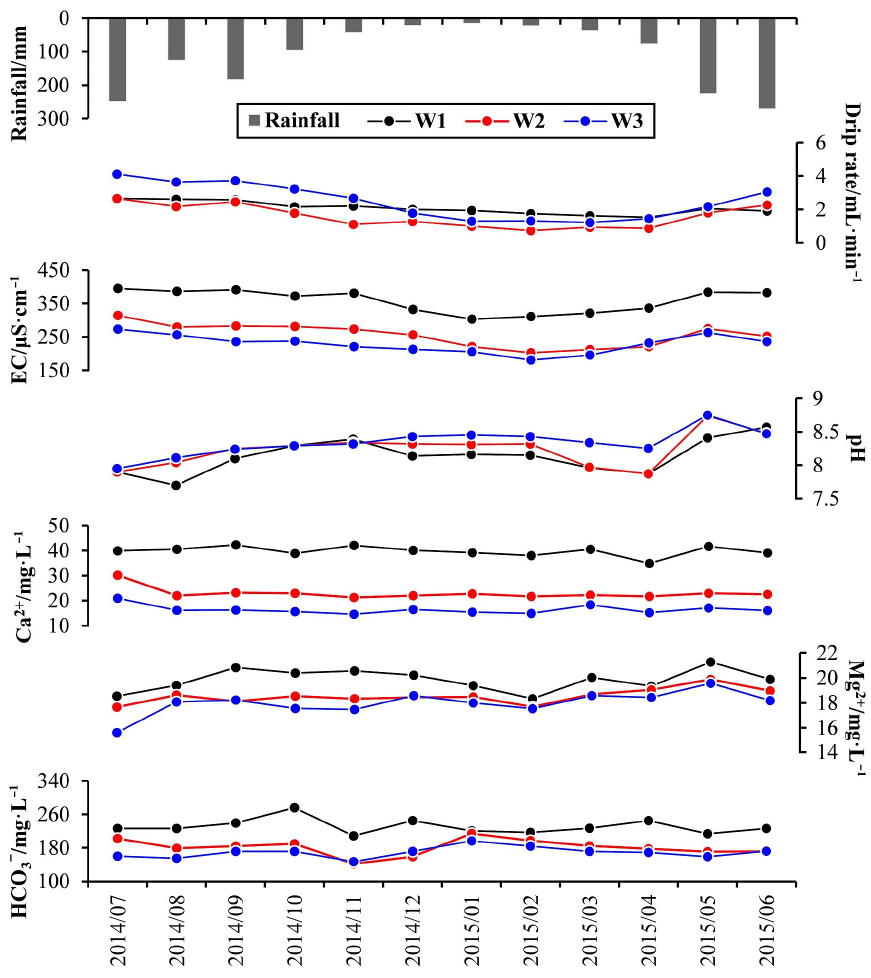
Figure 4. Time series of major hydrologic and hydrogeochemical characteristics for cave drip water in the Shijiangjun Cave (2014~2015).